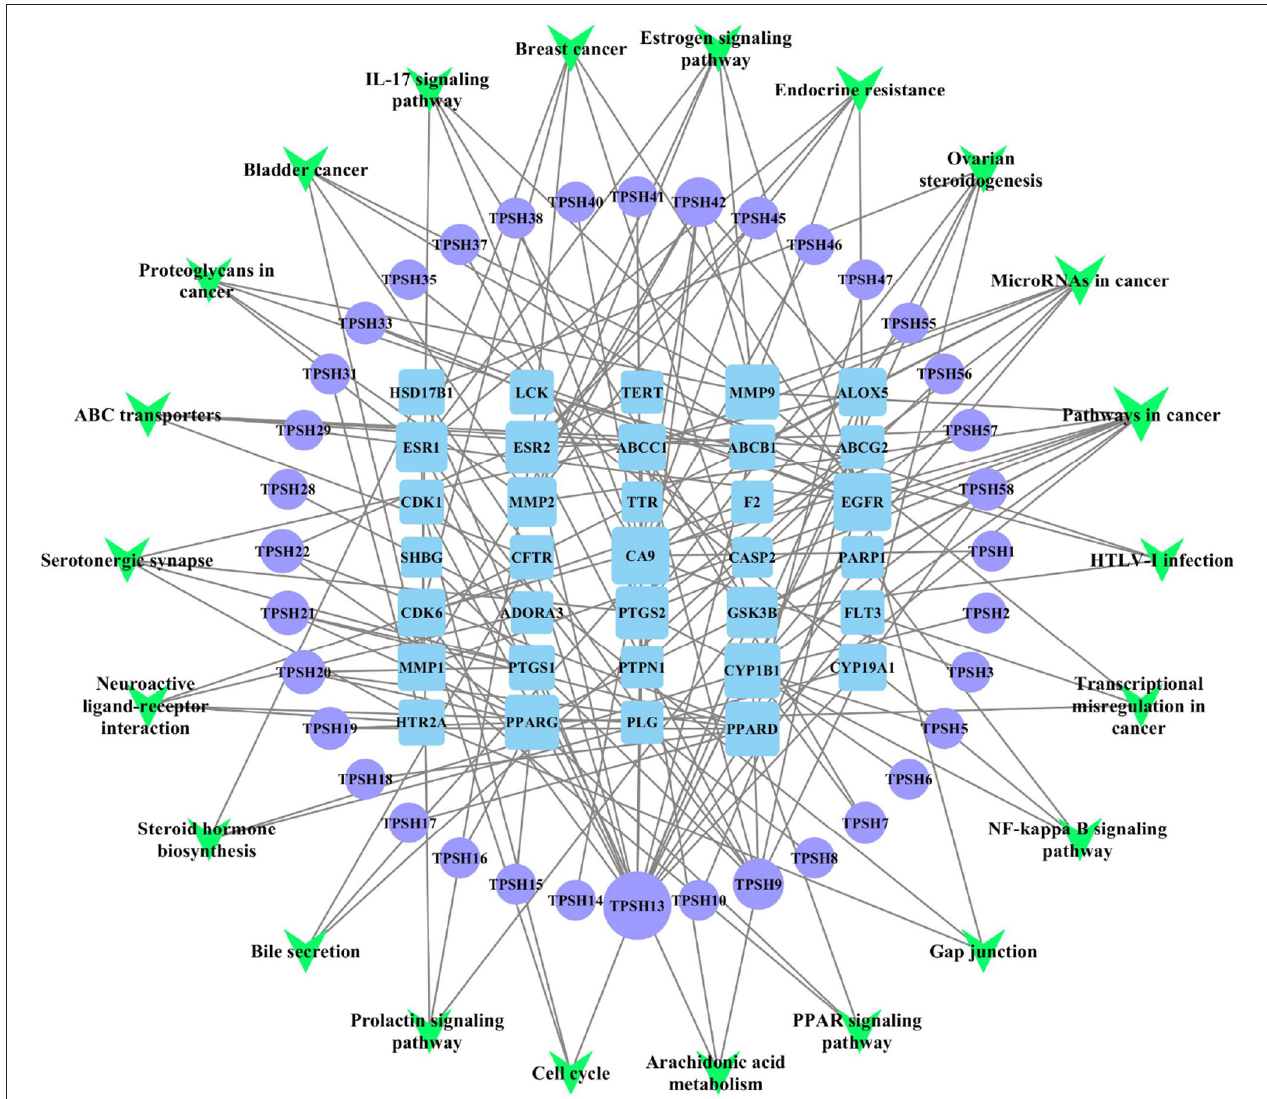
FIGURE 4 | Component–target–pathway (C-T-P) network of D. officinale for CRC. The purple circles represent the active components of D. officinale , the blue squares represent the common targets, and the green inverted triangles represent the main pathways. Node size is proportional to its degree. The larger the area is, the more important it is in the